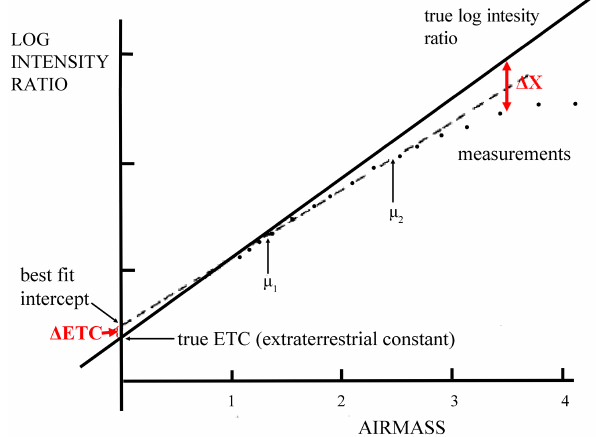
Figure 1. Schematic presentations of the stray light errors induced on log intensity ratios ( (cid:49)X ) and on the determination of extrater- restrial constants ( (cid:49) ETC) (Basher, 1982;